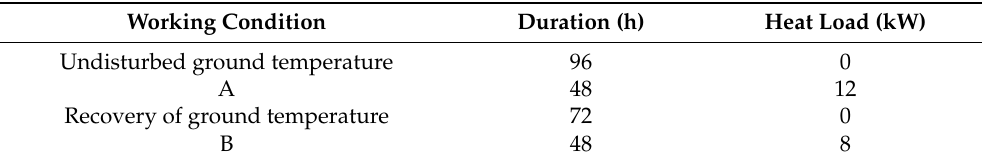
Table 4. Test working condition